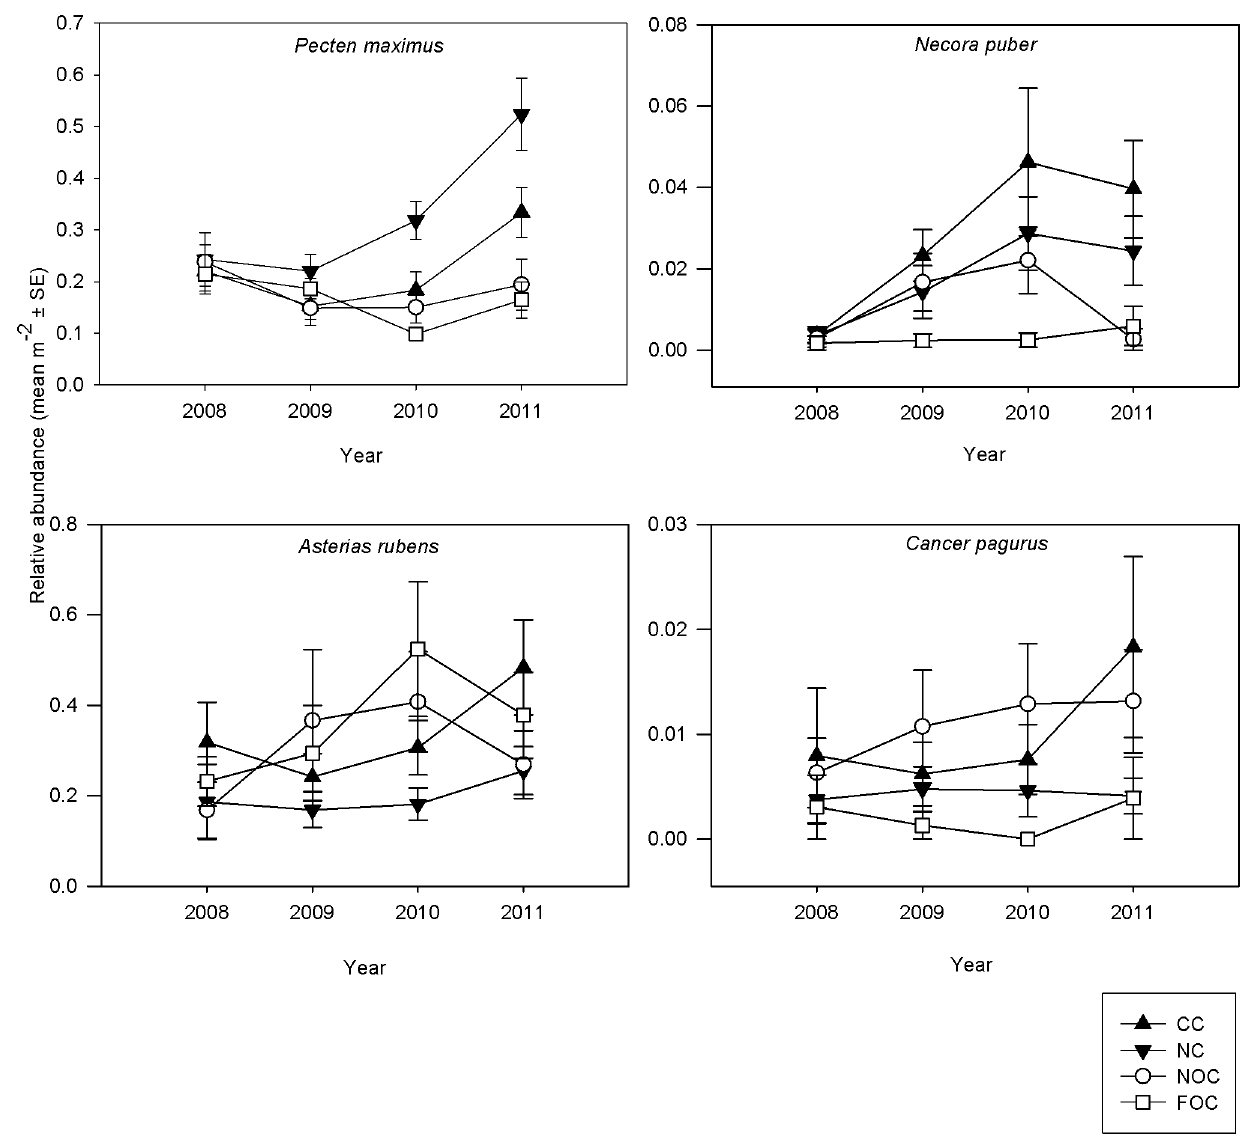
Figure 6. Relative abundance (mean m 2 2 ± SE) of mobile indicator species per treatment (CC = closed control, NC = new closure, NOC = near open control, FOC = far open control), per year (2008, 2009, 2010, 2011).